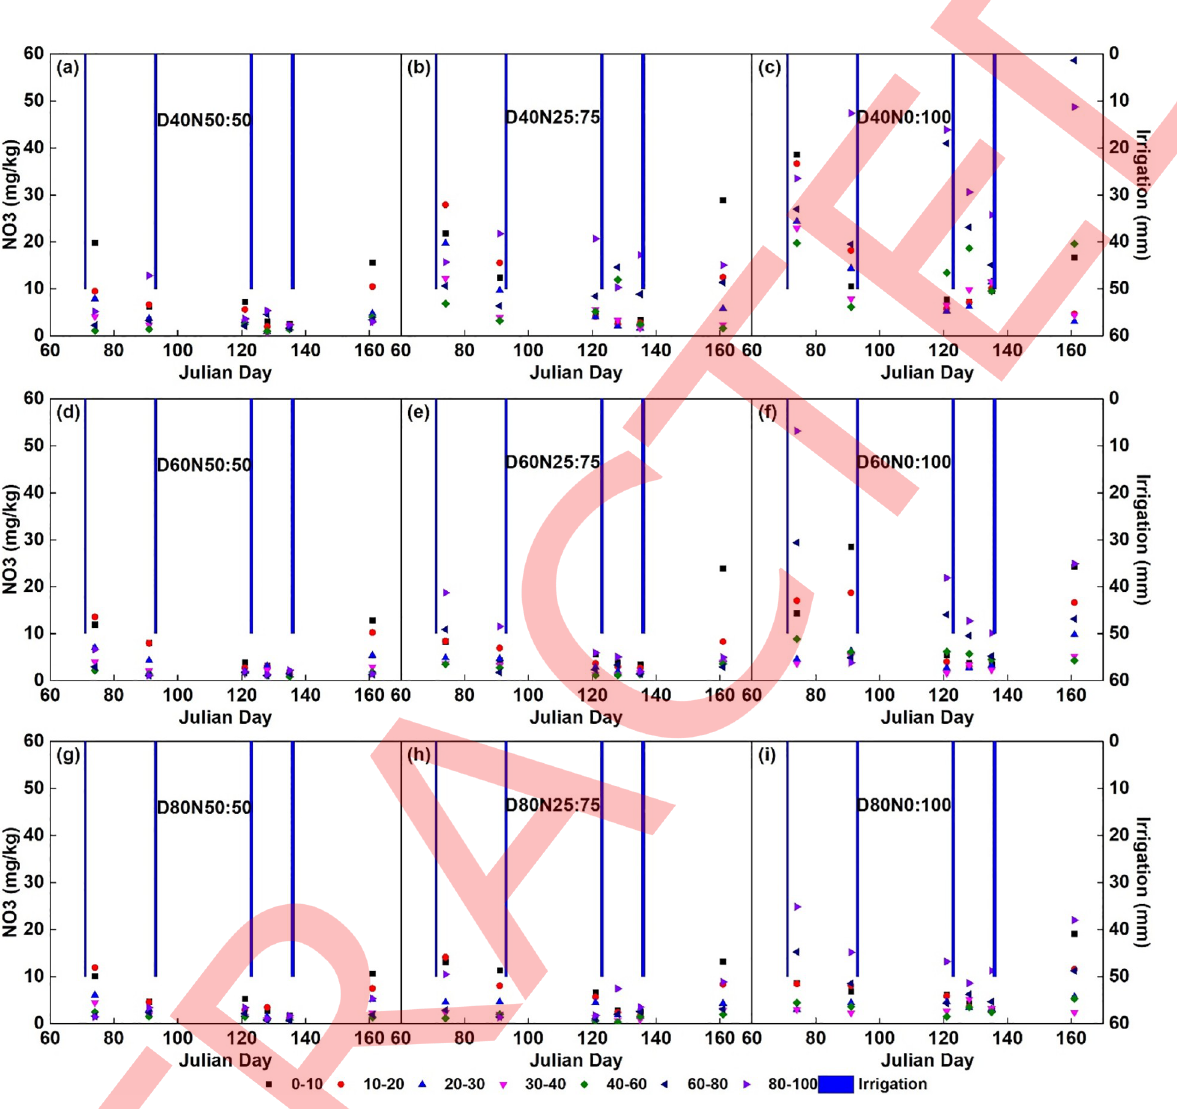
Fig 5. Soil NO3—N contents of various LS and NAMs during the 2019 wheat growing